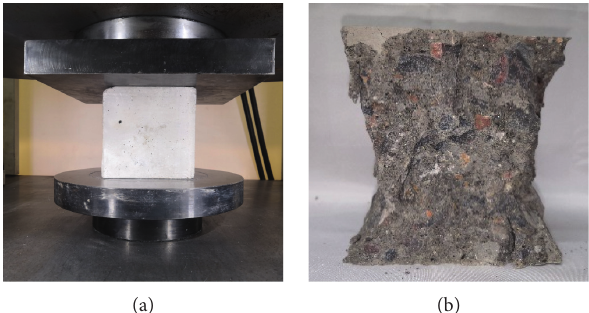
Figure 1: Loading method and breaking patterns. (a) Schematic diagram of compressive loading. (b) Compression damage pattern.